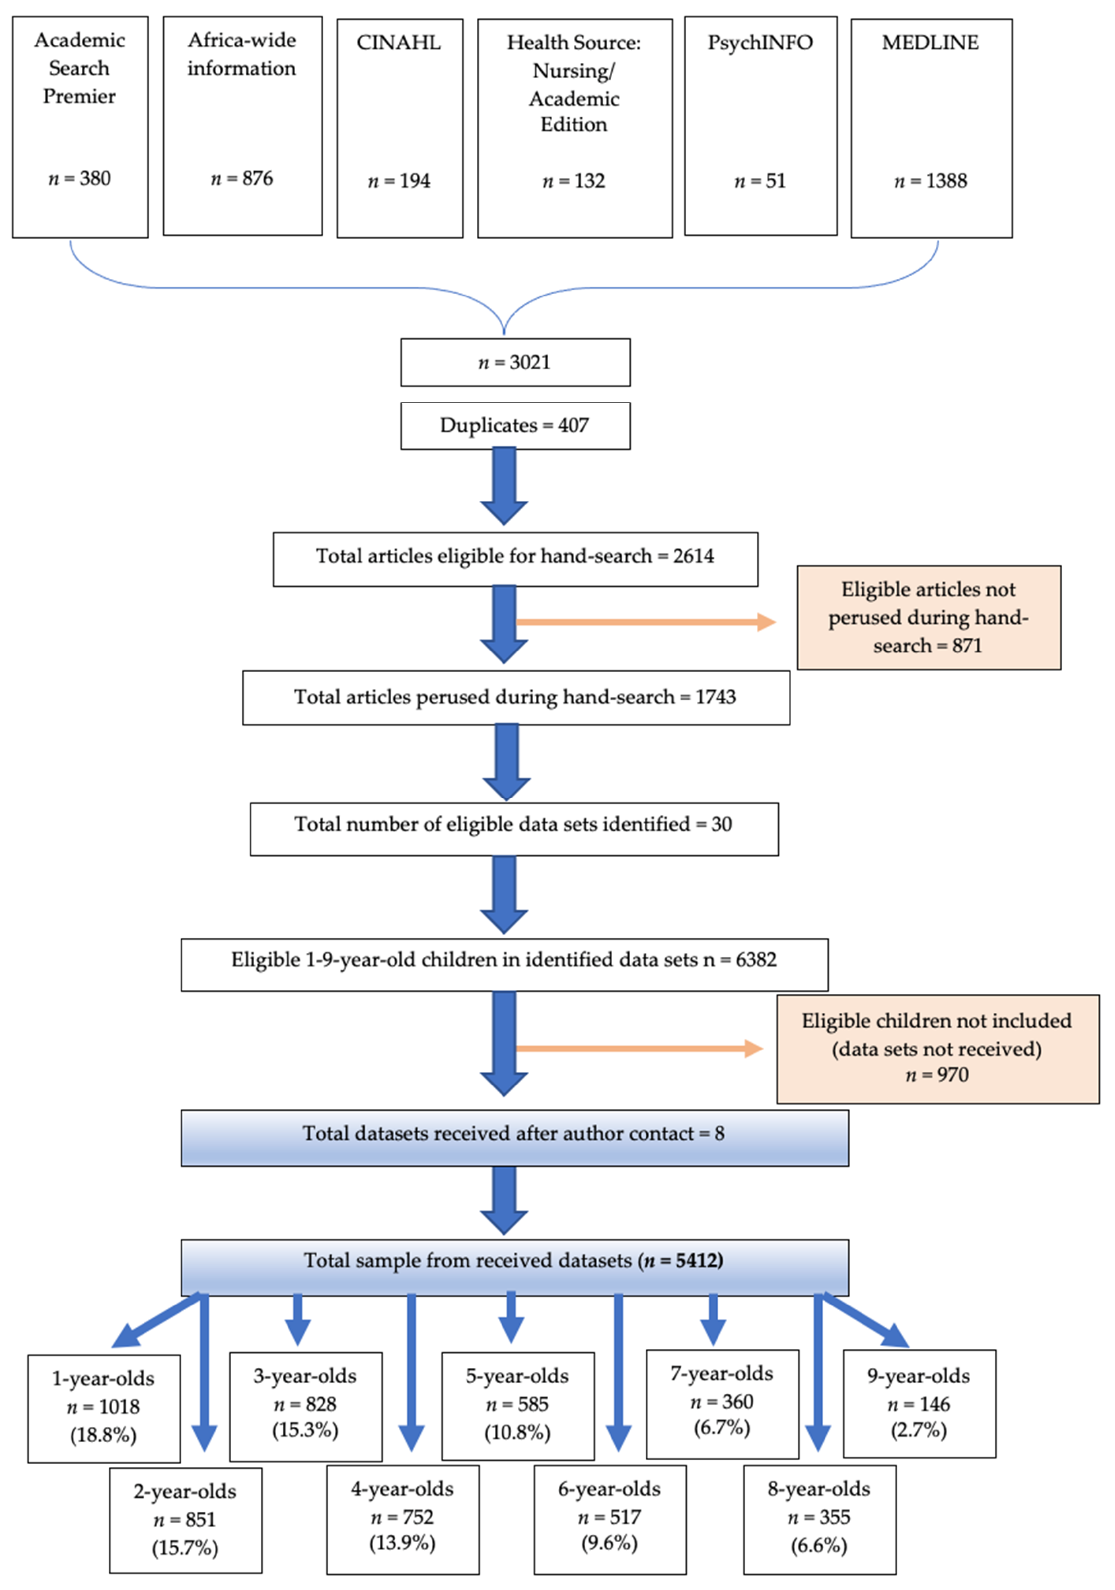
Figure 1. Flow diagram of search strategies and results.